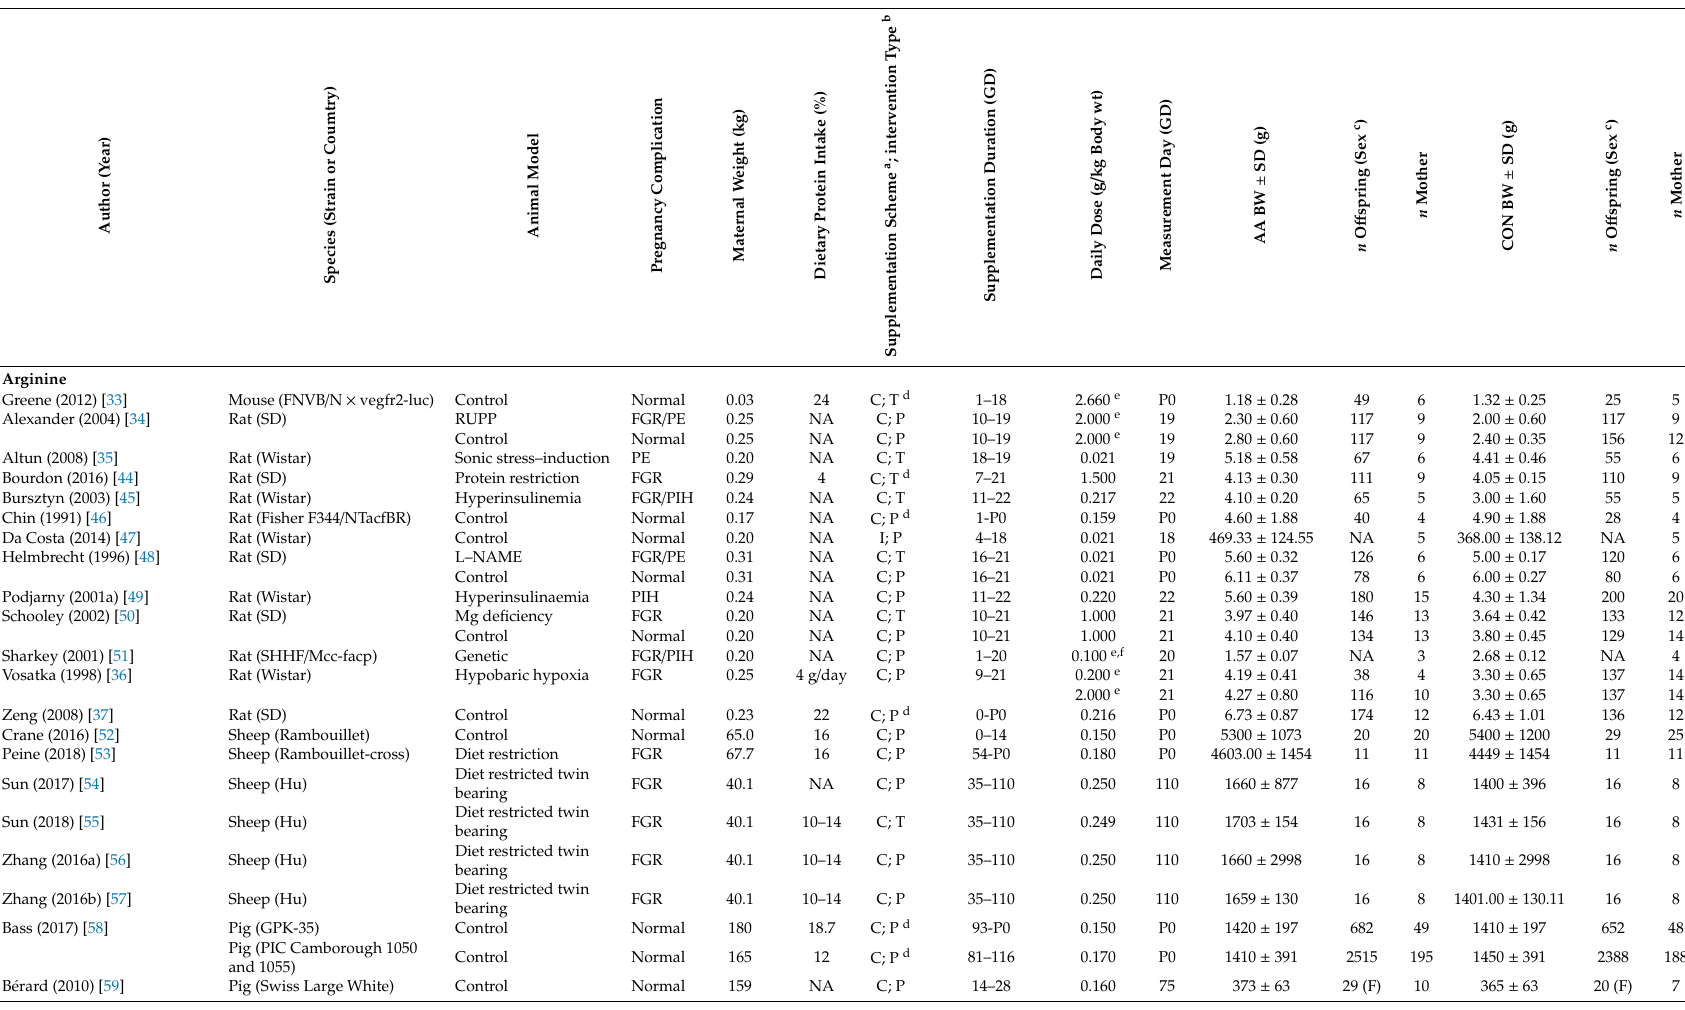
Table A5. Data-extraction of included animal and human studies on birth